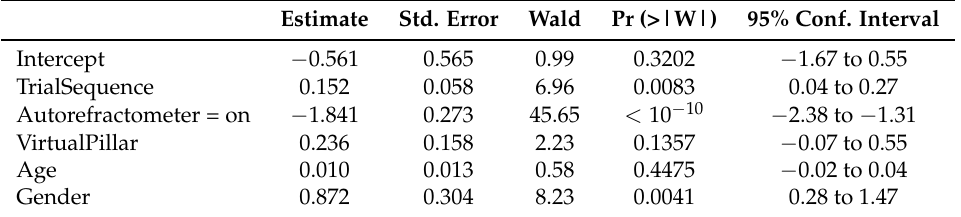
Table 1. Coefficients and p -values of the experimental variables of a linear model fitting using generalized estimating equations with correlation structure = exchangeable. The p -values show that Autorefractometer is the main contributor to the model but not the only one, also gender and TrialSequence are